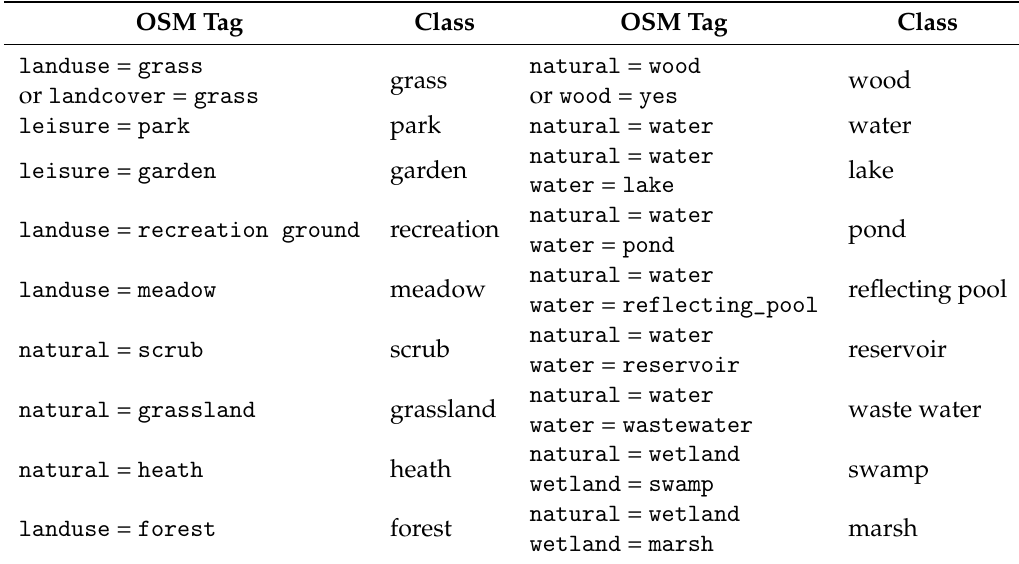
Table 1. Mapping between OSM tags and some of grass-related and water-related overlapping